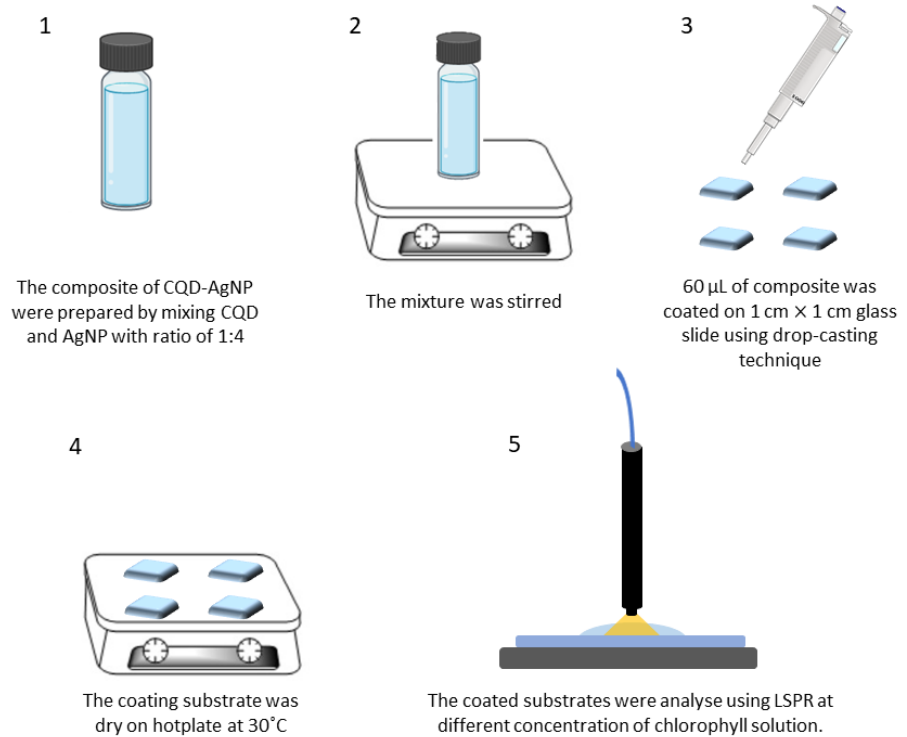
Figure 2. Experimental procedure for the preparation of a substrate coated with AgNPs and a AgNP–CQD composite.